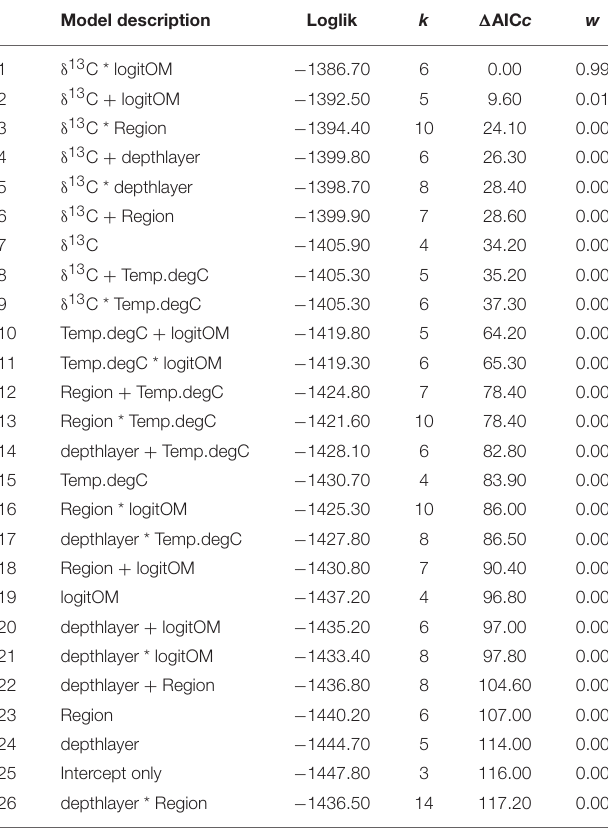
TABLE 2 | AIC-based model selection results for linear mixed effects models of [HCO − 3 ] in in situ bottle measurements, ordered from best to